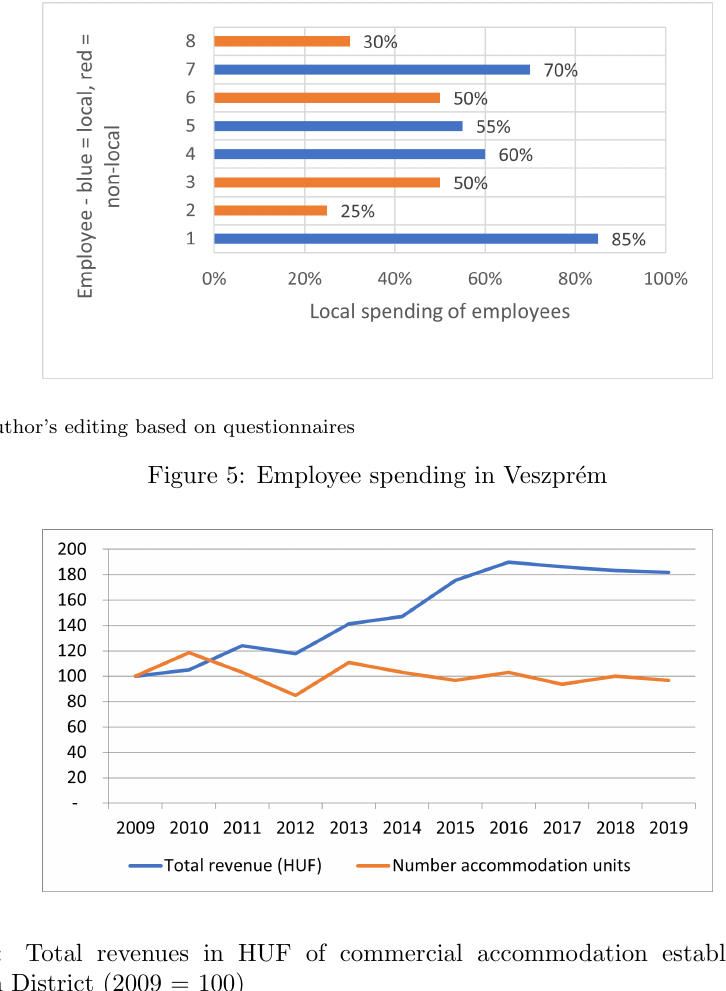
Figure 6: Total revenues in HUF of commercial accommodation establishments in Veszpr´em District (2009 =